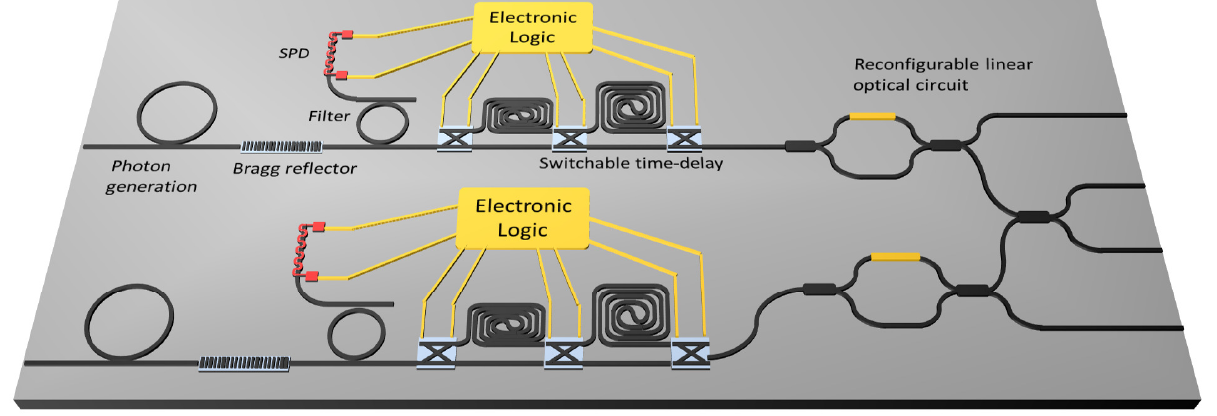
Fig. 1. Schematic of a CMOS-compatible quantum photonic chip that includes single-photon sources and reconfigurable linear optical cir- cuit.